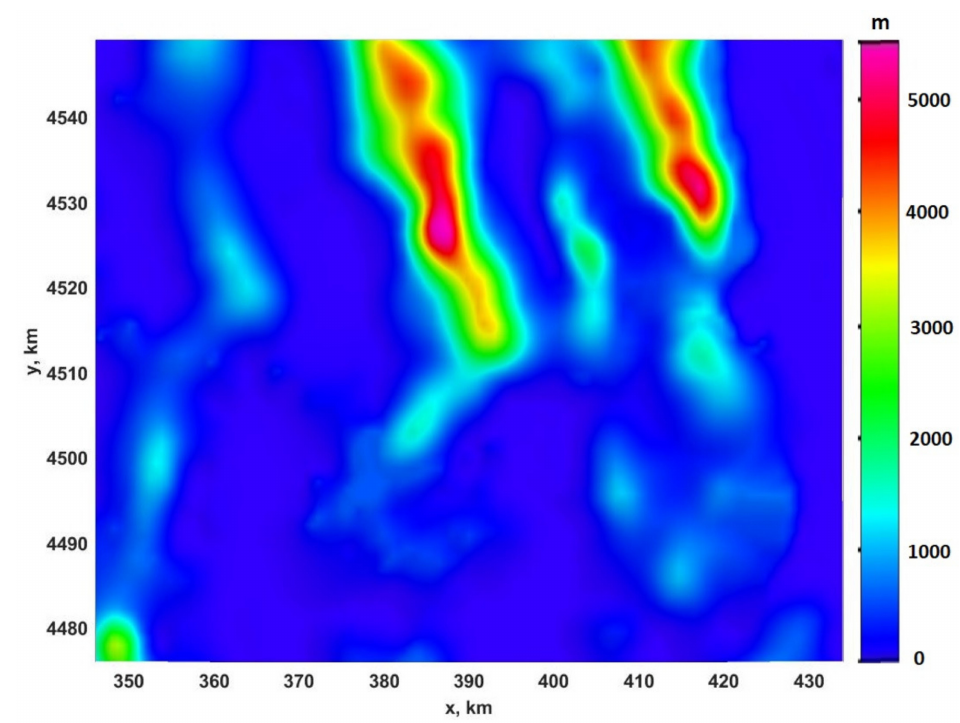
Figure 4. Map of the depth to Mesozoic basement produced by USGS (after [2]). We present in Figure 5 the density contrast surface produced by the depth-to-basement inversion with the density contrast equal to 0.3 g/cc. This value was determined based on known data and the best convergence of the inversion. The iterative inversion ran until the L2 misfit between the observed and predicted data reached a level of approximately 7%.